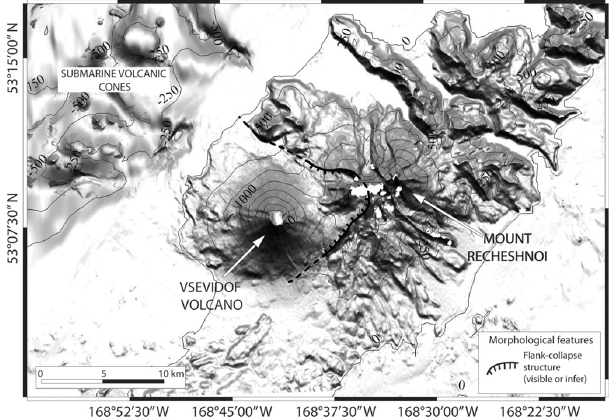
Fig. 12. Position of amphitheatre walls on the SW side of Rechesh- noi.